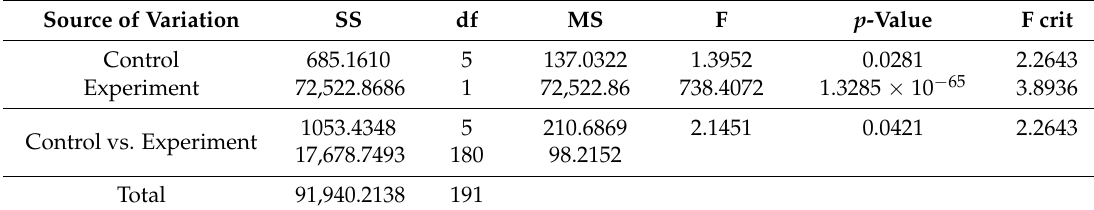
Table 4. Two way ANOVA with replication analysis of Pscore and execution